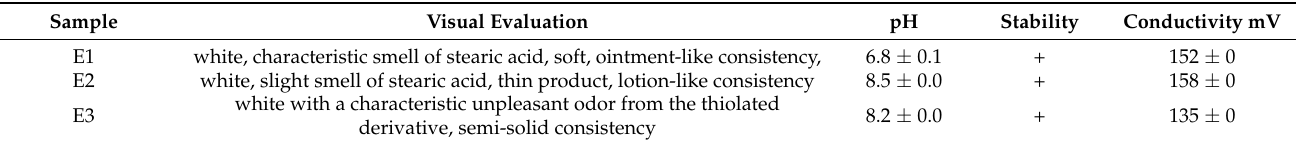
Table 3. Physicochemical properties of samples E1–E3, + stable sample, − unstable sample. Sample Visual Evaluation